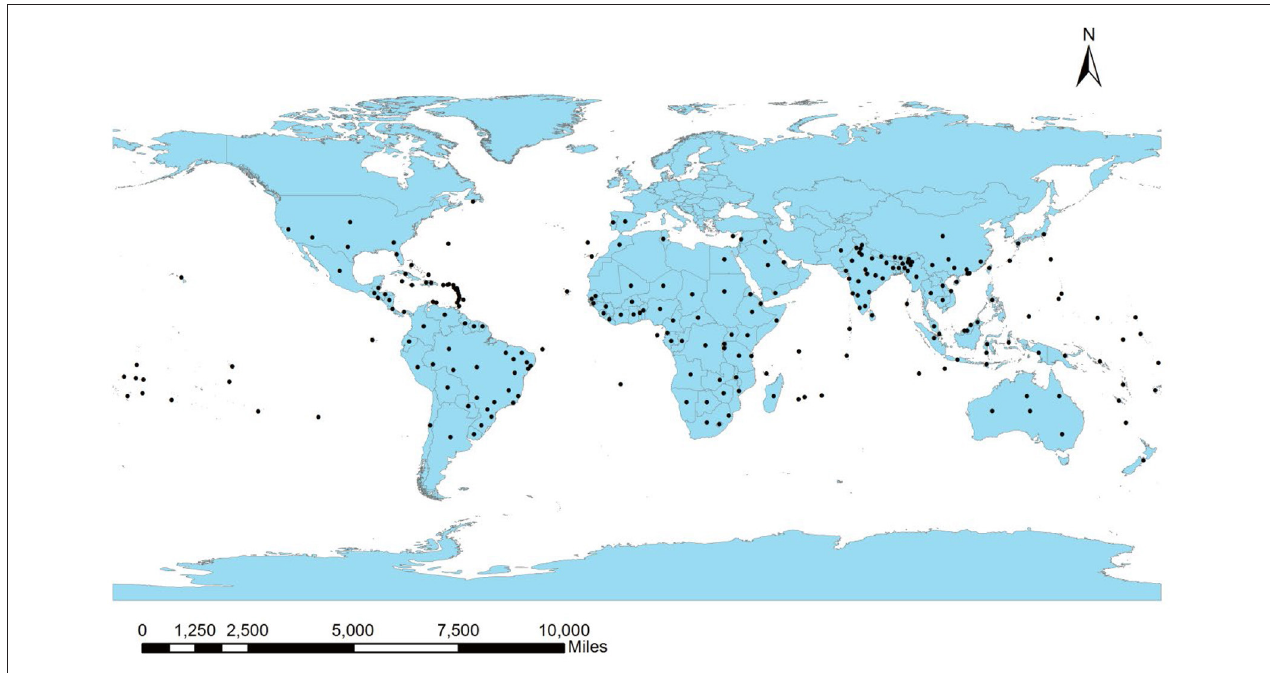
FIGURE 2 | Global distribution of Leucaena leucocephala